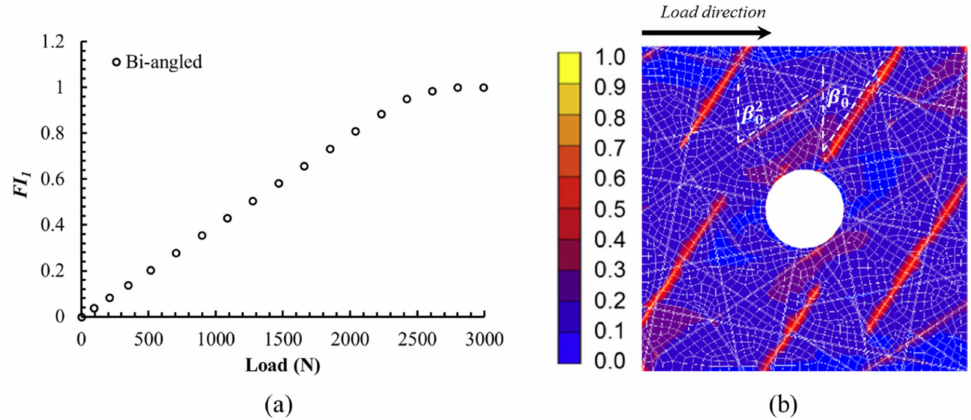
Figure 9. ( a ) Failure index FI 1 of the slits in 0 ◦ ply with the increase of load, and ( b ) the damage image of the slits in 0 ◦ ply at the load of 2.8